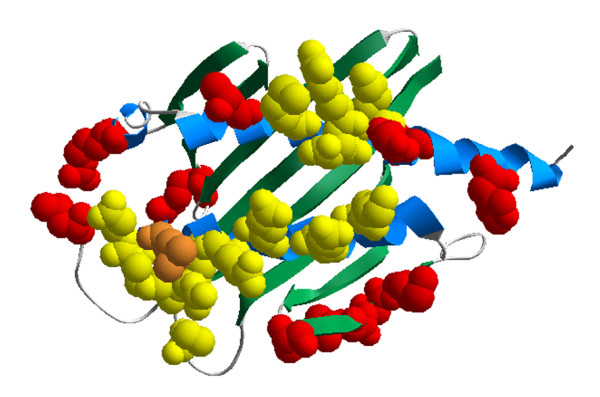
Positively selected ULBP sites mapped onto the crystal structure of human ULBP3. Positively selected cattle ULBP sites mapped onto the structure of human ULBP3. Tertiary structure of human ULBP3 [PDB: 1KCG, chain C] showing the spatial arrangement of homologous cattle ULBP residues under positive selection (>90% probability) as well as the human ULBP3 residues that interact with the NKG2D molecule. The human ULBP3 backbone appears in blue and green. Twelve of 13 cattle ULBP sites under positive selection are mapped onto the structure, and eleven appear as red space-filling residues. Thirteen of the fourteen human ULBP3 sites that interact with NKG2D appear as yellow space-filling residues. One site corresponding to both a selected cattle ULBP site and a human ULBP3 site that interacts with NKG2D appears in orange.